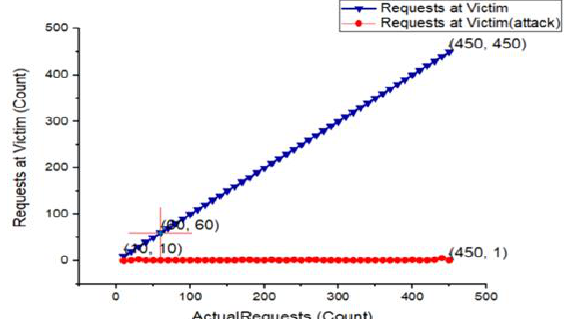
Fig 7: Variation of Actual Requests Vs tcpPassiveOpens